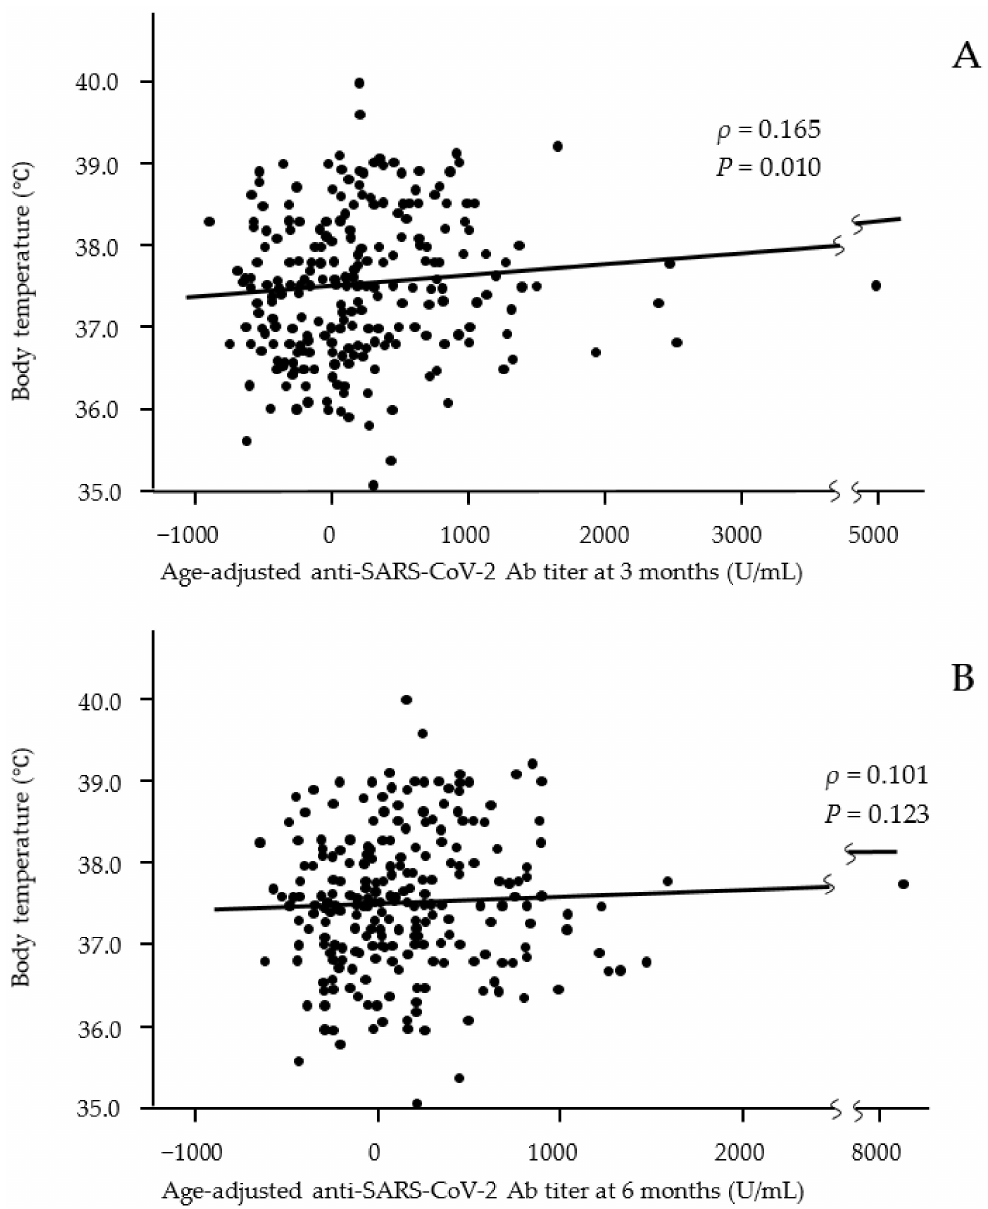
Figure 2. Relationships between body temperature after the second vaccine dose and age-adjusted anti-SARS-CoV-2 Ab titers at 3 months ( A ) and 6 months ( B ) after the second dose of the vaccine. Significant positive correlations were observed at 3 months after vaccination but not at 6 months. ( A : n = 243; B : n =